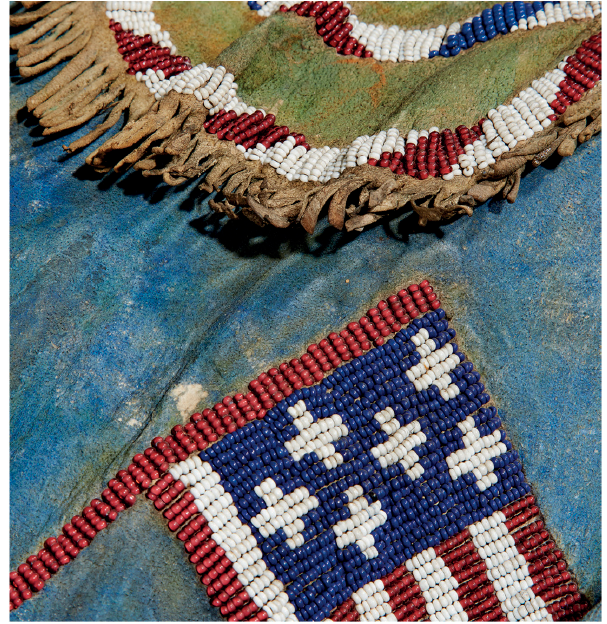
Figure 7. Detail of Plains Indian buckskin tunic (Figure 1), c. 1888, Musée de l’Atelier